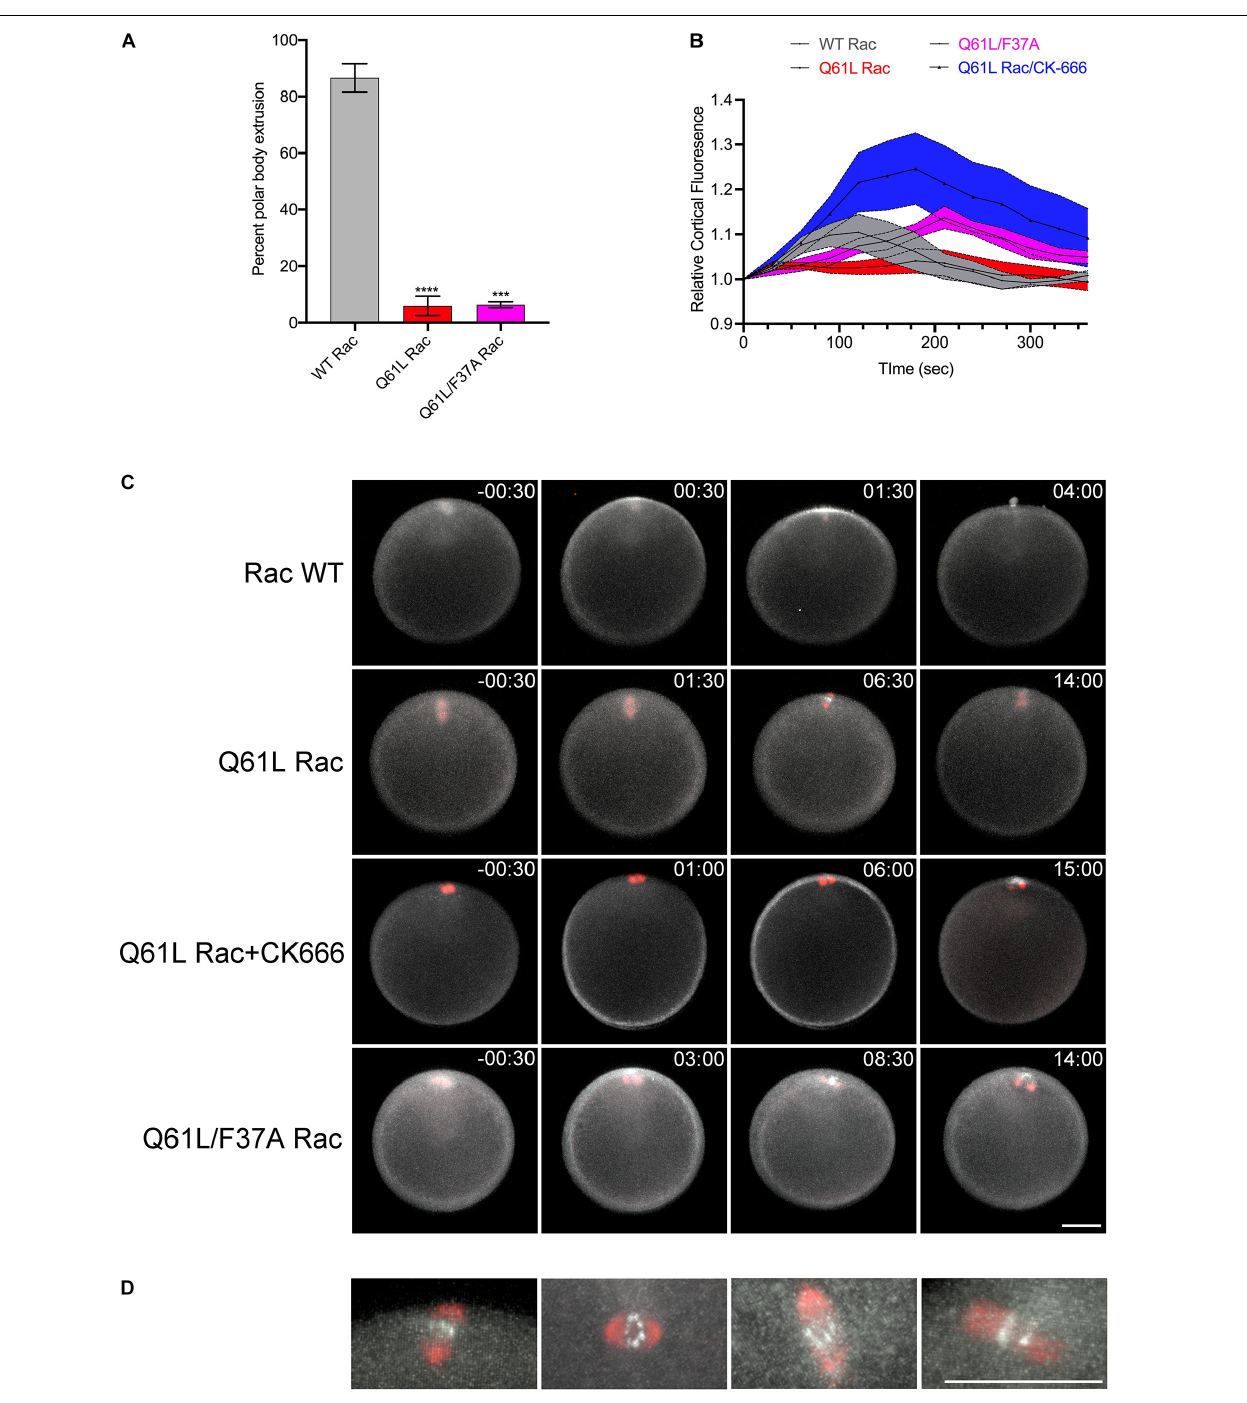
FIGURE 5 | Rac and Arp2/3 directly antagonizes Rho activation during meiosis I. (A) Quantification of polar body formation in P. miniata oocytes injected WT, Q61L or Q61L/F37A Rac (final intracellular concentration 1.8 µ g/ml), 200 oocytes scored per condition per experiment (Mean ± SEM, *** p < 0.001; **** p < 0.0001). (B) Cortical Rho activity during the surface contraction wave (SCW) in oocytes expressing WT Rac (gray), Q61L Rac (red), Q61L/F37A Rac (magenta) or Q61L Rac oocytes treated with 100 µ M CK-666 (blue). Rhotekin-GFP fluorescence was measured for the entire cortex, where time 0 denotes the initiation of the SCW at the vegetal pole. Mean ± SEM, 7 oocytes per condition. (C) SCW and polar body extrusion in P. miniata oocytes co-expressing rGBD-GFP (white), mCherry-EMTB (red) and Rac variants described in panel (B) . Time point indicate minutes post-initiation of the SCW. Bar, 50 µ m. (D) Examples of Rho activity associated with meiotic spindles after cytokinesis failure in Q61L Rac-expressing cells. The first panel is the same cell shown in panel (B) . Bar, 50 µ m.